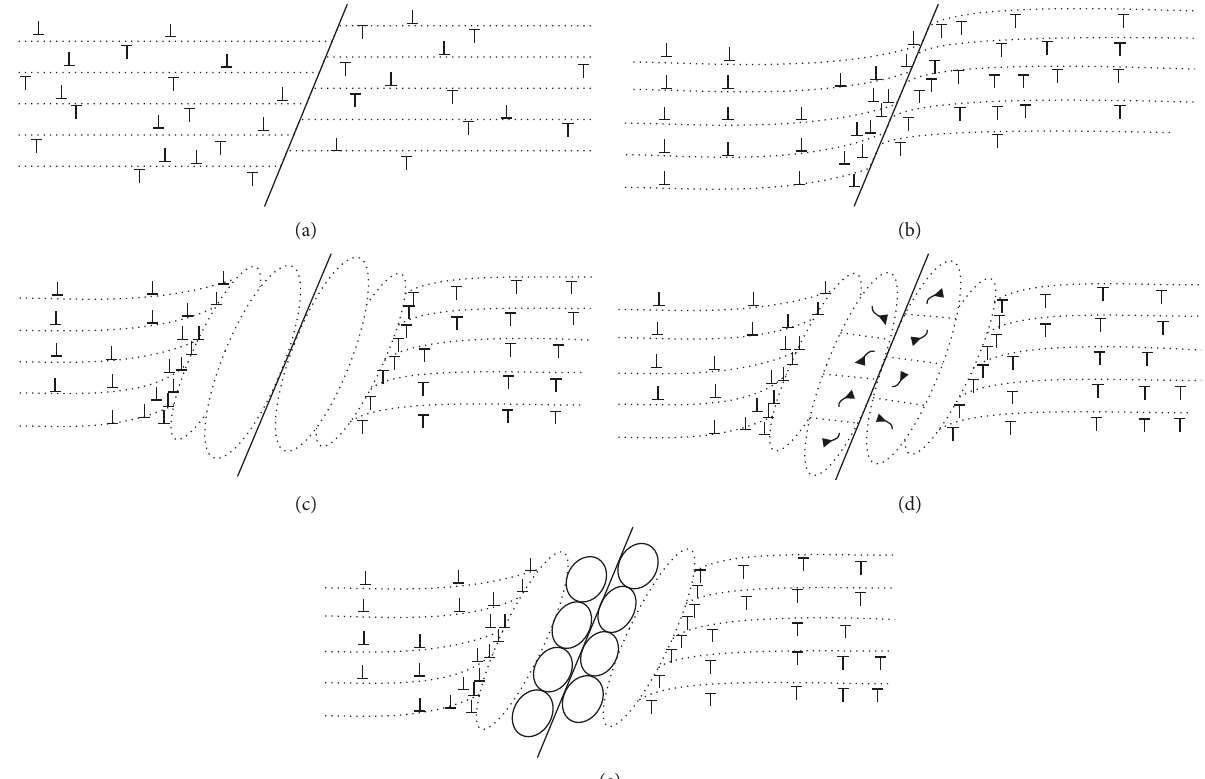
Figure 4: Schematic of the subgrains and ultrafine grain formation mechanism